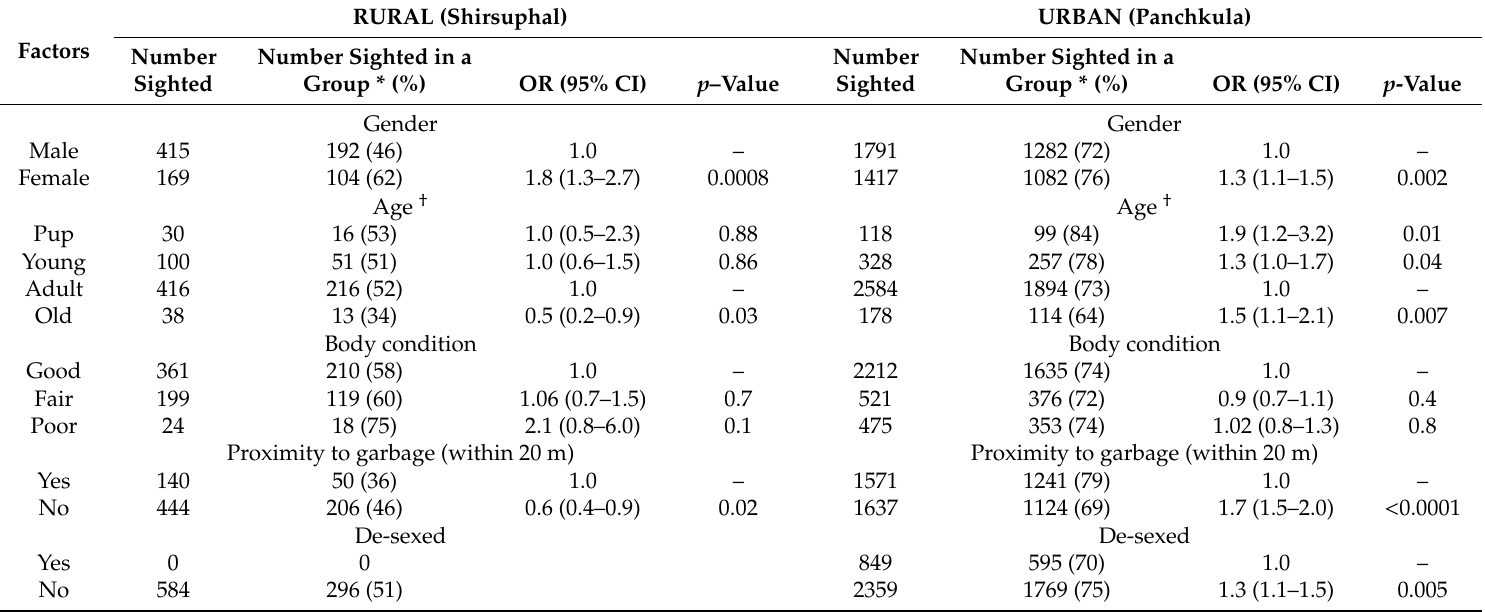
De-sexed De-sexed